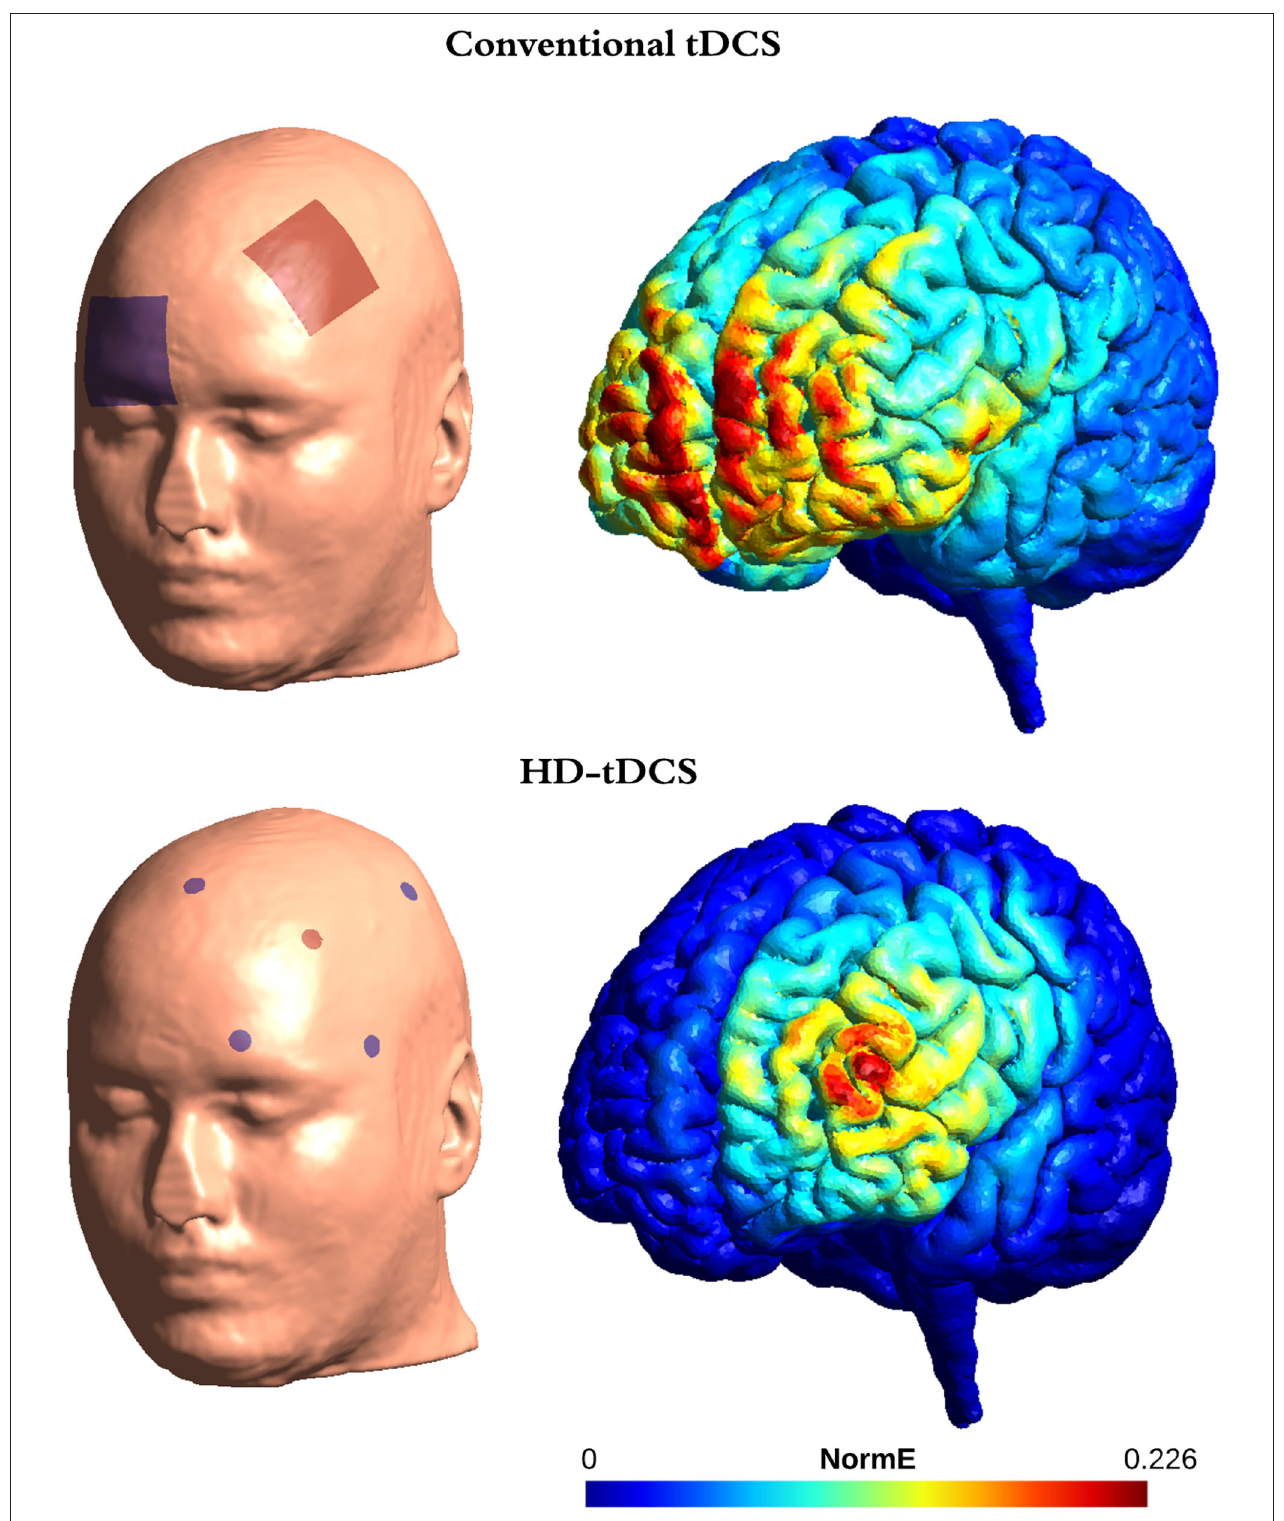
FIGURE 1 | Comparison between conventional tDCS and HD-tDCS montages targeting the left DLPFC. The top two inset displays the most commonly used montage to target the DLFC with conventional tDCS: active electrode (anode) placed over F3 and the reference electrode (cathode) over Fp2. The bottom two insets display the equivalent HD-tDCS montage: active electrode over F3 and 4 reference electrodes, placed at FP1, FZ, C3 and F7. For each montage, the left inset represents the location of each electrode on a three-dimensional head model and the right inset represents the simulated electric field on a standard brain. Red colors represent higher fields. We used Simnibs3.2.2 on the “Ernie” head model with the current intensity for the active electrode set at 1 mA.